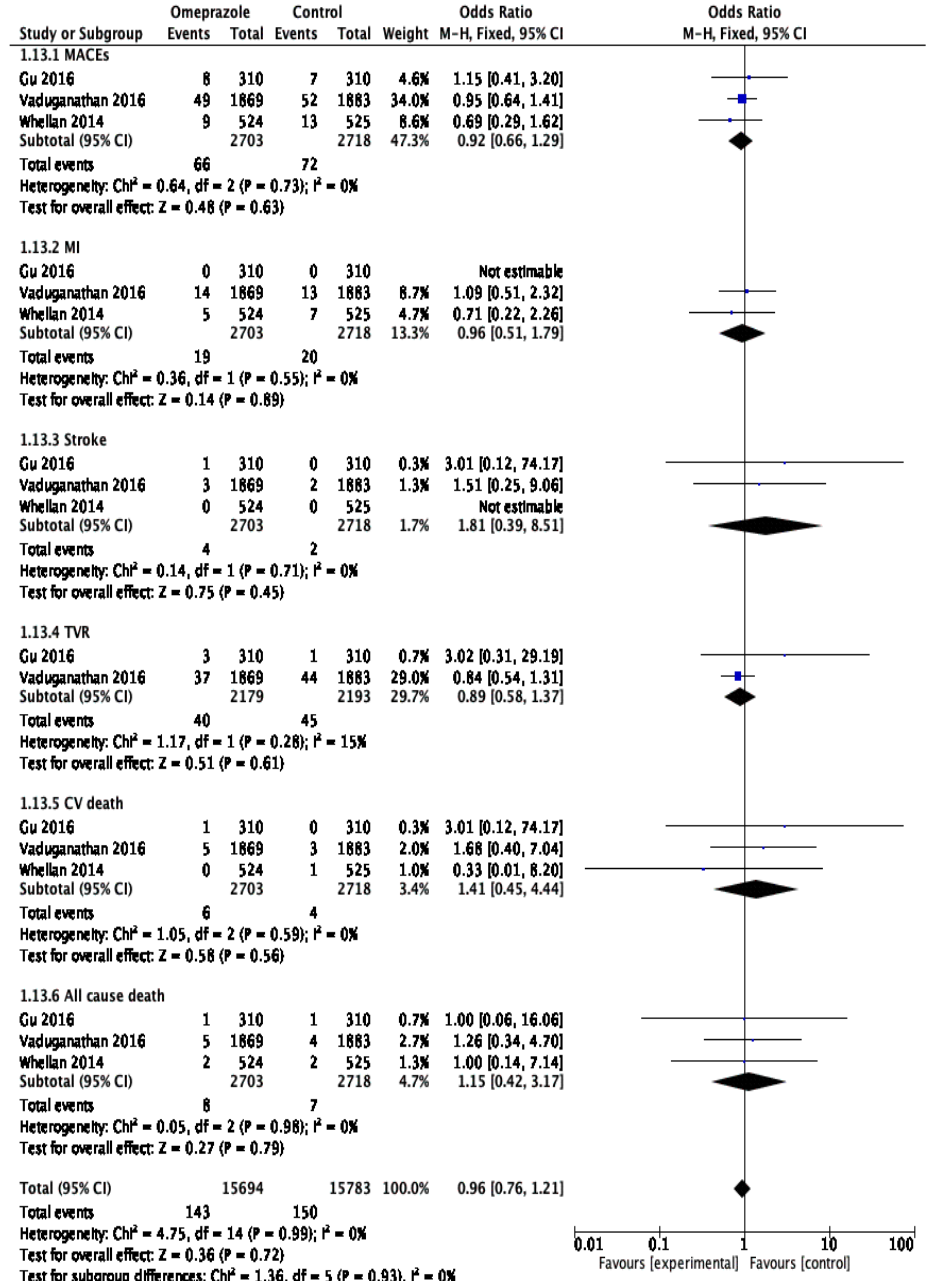
Figure 6. Forest plot illustrating the cardiovascular risk associated with long ‐ term omeprazole use.